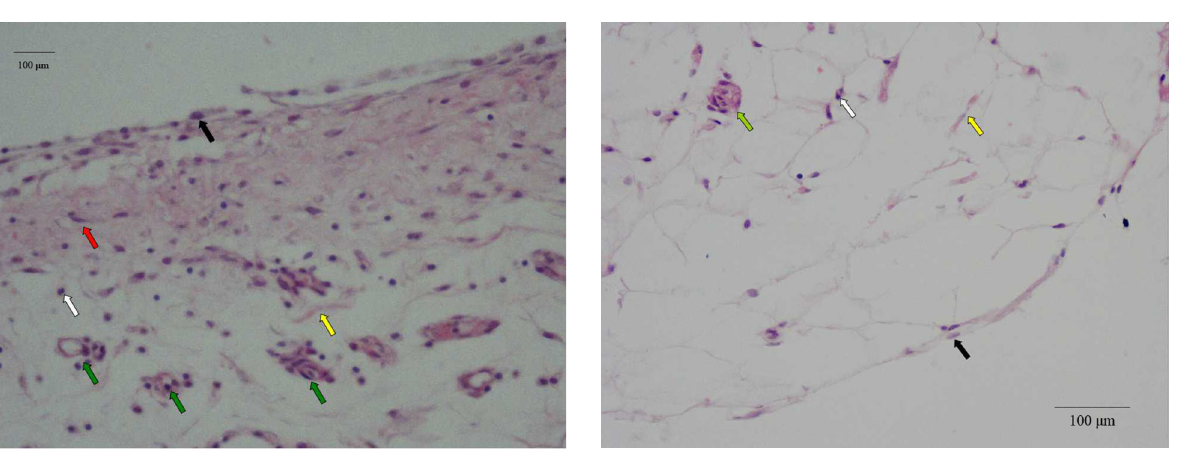
Figure 2. Hematoxylin-eosin staining of the serosa in a representative rat in group B (treated with sodium carboxymethyl cellulose [SCMC] only). The serosa has a partially repaired dissection surface with broken mesothelial cells (black arrow). Capillary proliferation (green arrows), fibroblastic proliferation (red arrow), dense collagen fibers (yellow arrow), and infiltration of granulocytes and macrophages (white arrow) were observed (100 6 ).